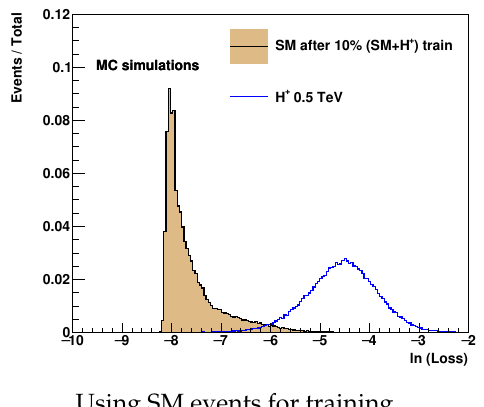
Figure 5. Distribution of the loss values for SM and H + events using 10% of SM events and 10% of H + for training (see the